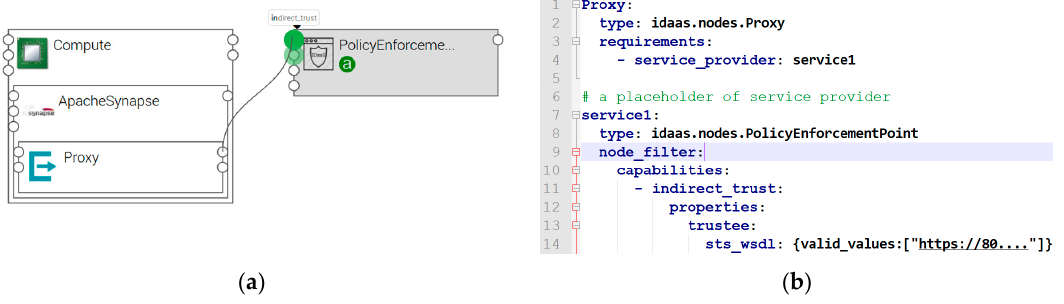
Figure 10. Topology editor ( a ) and topology description ( b ) for the shopping service.